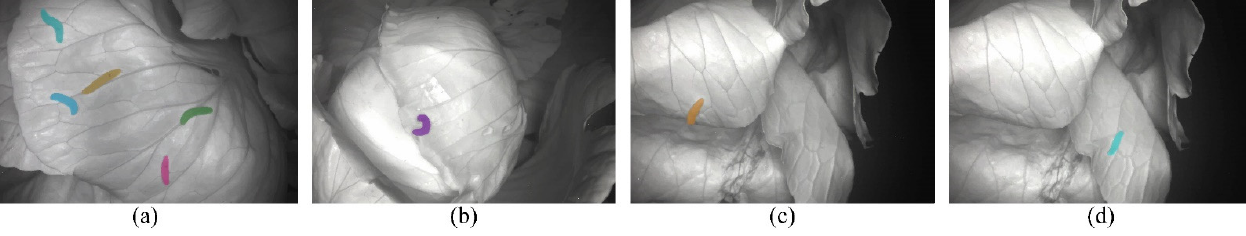
Figure 5. Visualization results of the ResNet50-based Mask R-CNN. ( a – d ) P. rapae larvae in different positions and postures taken from the collected NIR images. ( a ) Multiple pests, ( b ) curled pests, ( c ) occlusion state, and ( d ) dorsal position of the leaf.